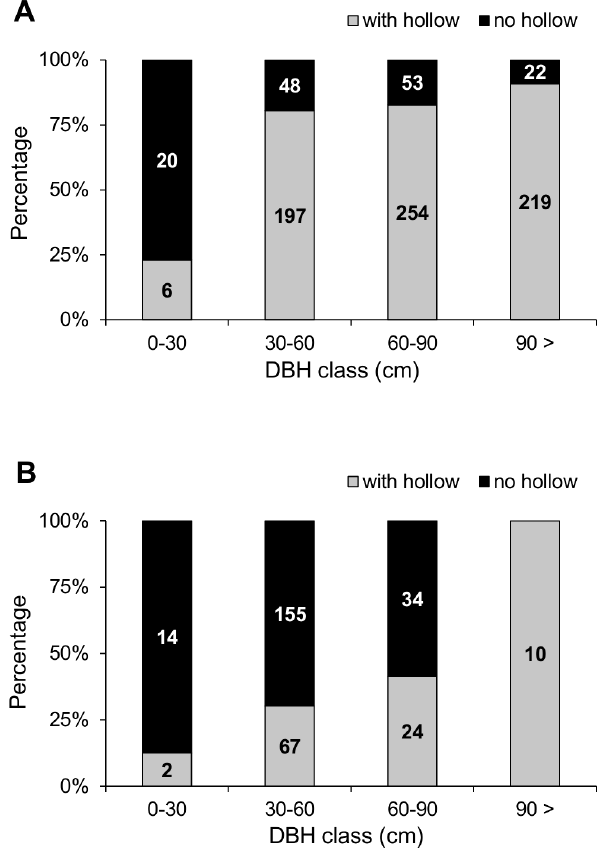
Figure 2. Proportions of hollowed trees in DBH classes. The proportion of hollowed willows in diameter classes (DBH class) for (A) pollards, and (B) unmanaged trees in the Dyje river catchment, Czech Republic. Numbers in bars indicate number of trees measured.